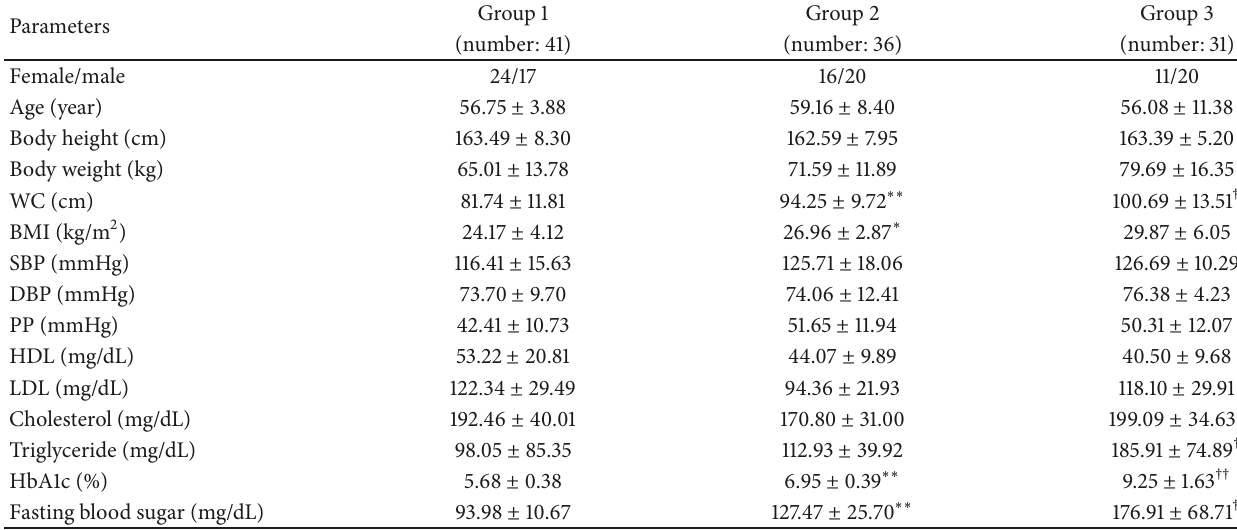
Table 1: Demographic, anthropometric, hemodynamic, and serum biochemical parameters of the testing subjects. Group Parameters